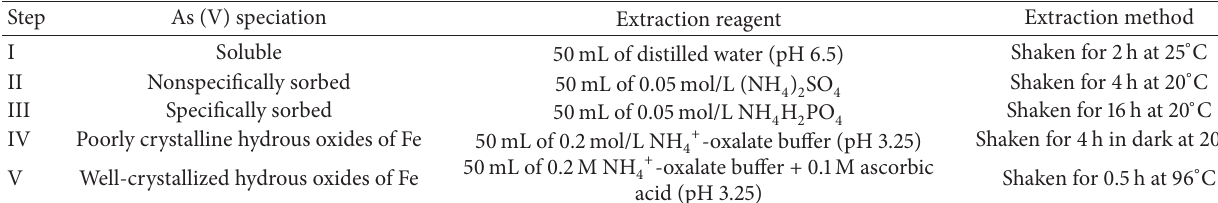
Table 1: Processes of the sequential extraction.